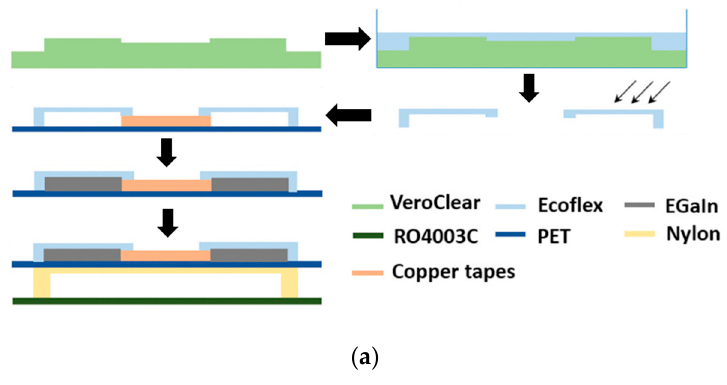
Figure 2. Microstrip patch antenna: ( a ) partially; ( b ) fully filled with EGaIn, inset on left depicting PDMS posts to ensure even liquid filling; and ( c ) simulated and measured response of the microstrip antenna